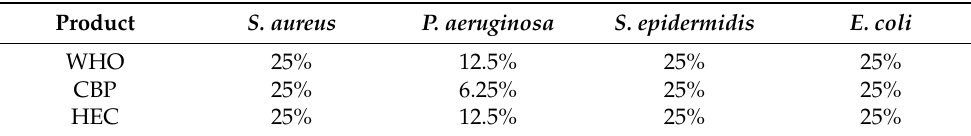
Table 6. MBC obtained for the formulation with hydroxyethylcellulose (HEC), for the formulation with Carbopol (CBP), and for formulation 1—WHO against the selected strains Staphylococcus aureus (ATCC 6538), Pseudomonas aeruginosa (ATCC 9027), Staphylococcus epidermidis (ATCC 12228), and Escherichia coli (ATCC 87394) (n = 2; r = 2).